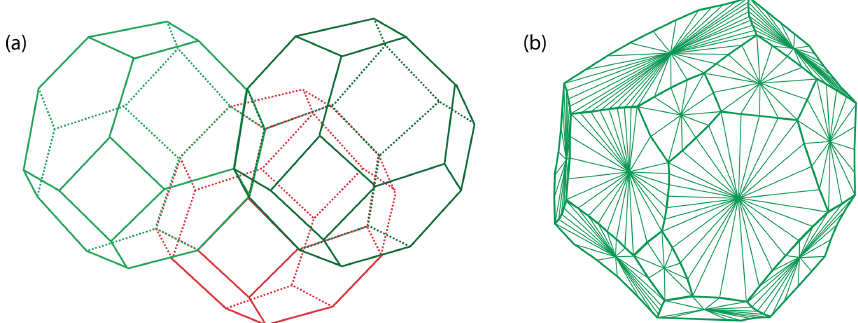
Figure 9. Grain shapes in polycrystalline materials: (a) the theoretical tetrakaidecahedral close-packed configuration with perfectly planar faces and (b) a simulated polyhedron grain with realistic curved faces (redrawn from Lazar et al., 2011).